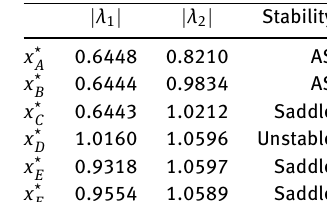
Table 6: Anaerobic digestion fixed points for u = 0.47 , x in